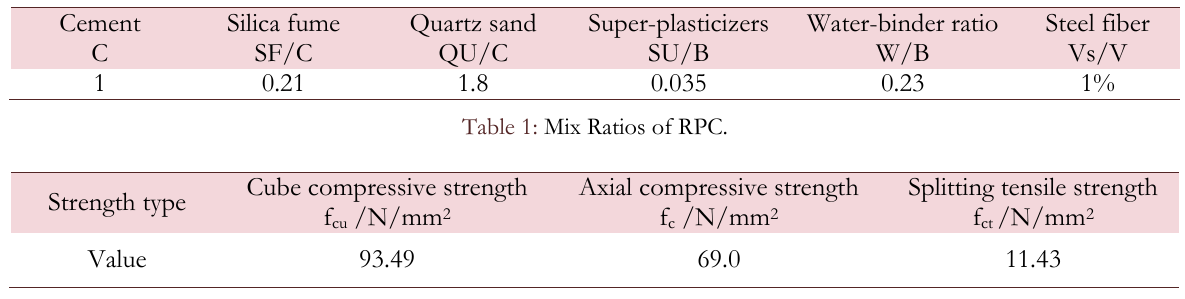
Table 2: Mechanical properties of RPC.